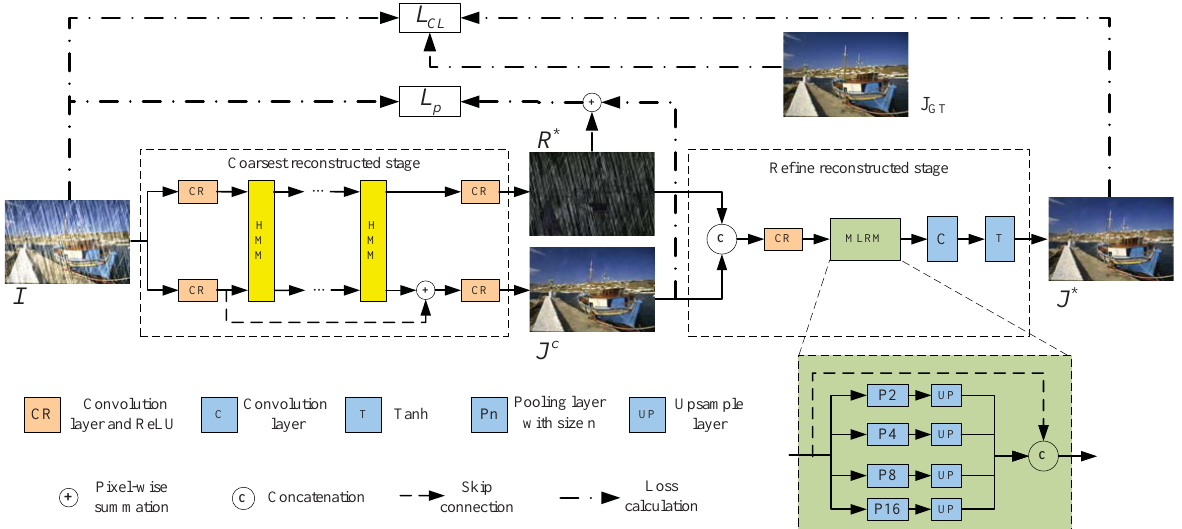
Figure 4. The structure of the proposed PHMNet. The HMM blends and modulates the features of the rain-free image and rain streaks. The MLRM concatenates and refines the feature. L p and L CL denote the physical loss term and contrastive-learning loss term,